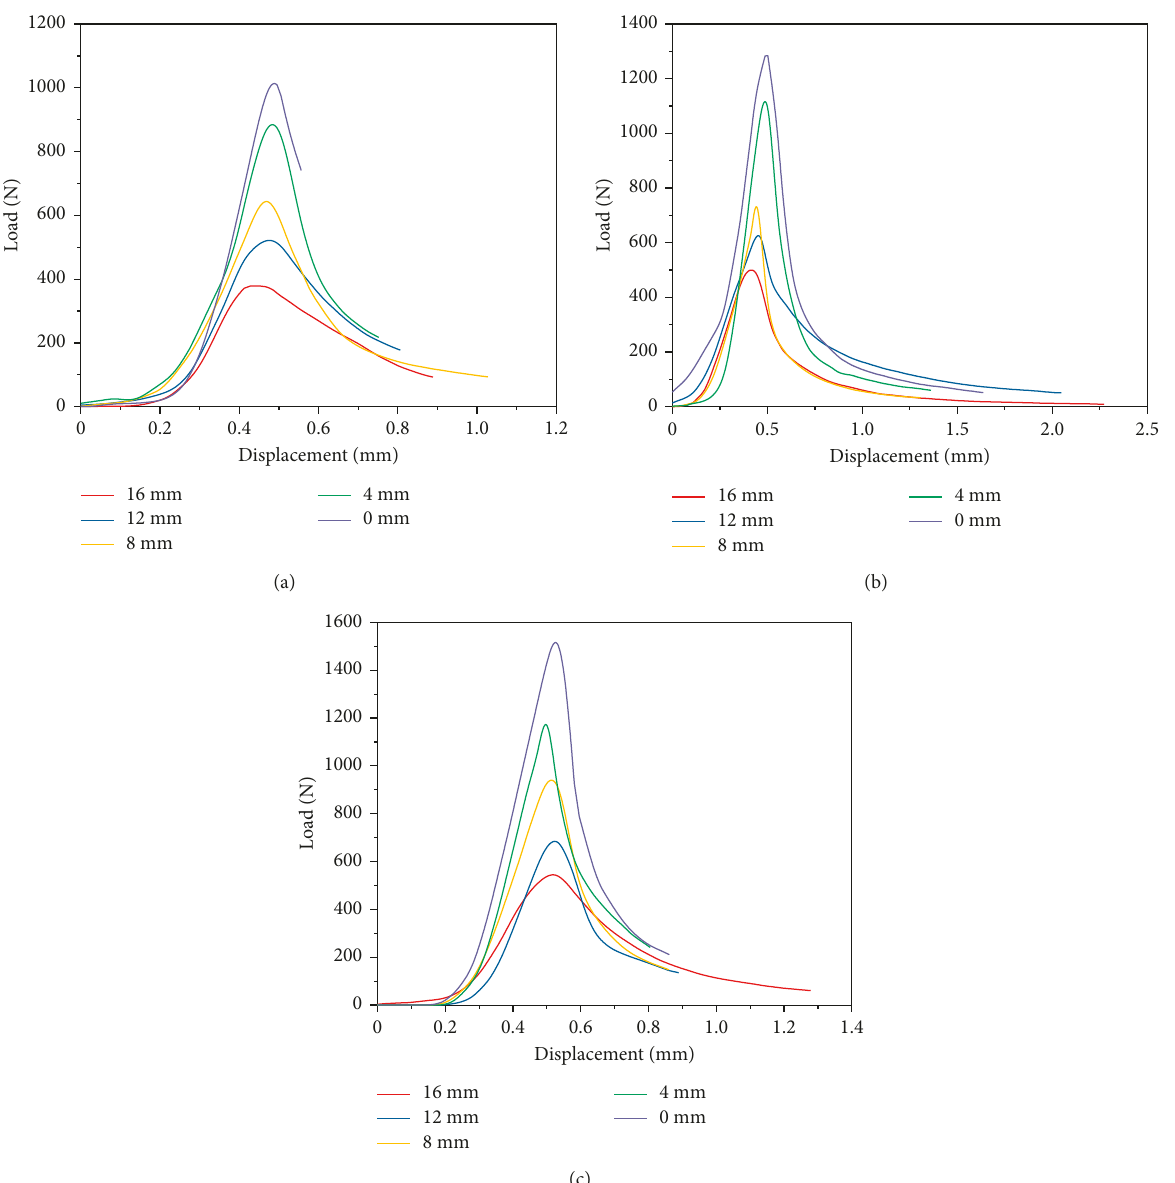
Figure 5: Load-displacement curves for different notch depths: (a) AC-13, (b) AC-16, and (c)